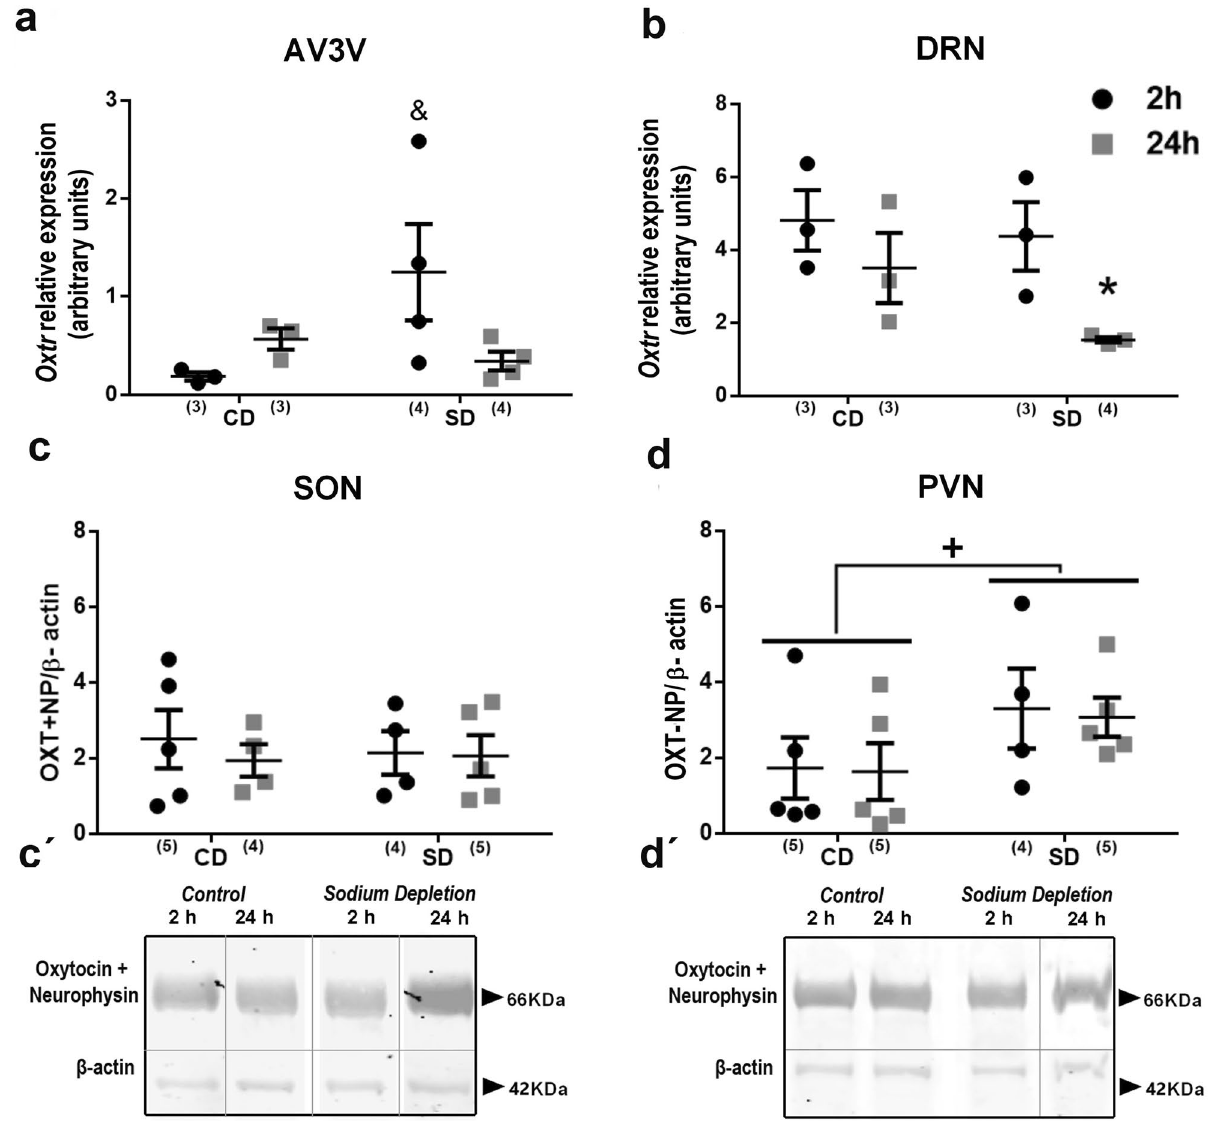
Figure 6. Brain oxytocin system expression after sodium depletion. Relative mRNA levels of oxytocin receptor ( Oxtr ) in the AV3V ( a ) and DRN ( b ) and relative protein expression of Oxytocin + neurophysin (OXT-NP) in the SON ( c ) and PVN ( d ) at two and 24 h after sodium depletion. Western blot detection of OXT-NP protein expressed in SON(c’) and PVN(d’). Values are mean ± SE (number of cases indicated by the individual points in each case). ( a ) & p < 0.05 significant difference between SD two h vs. other groups. ( b ) * p < 0.05 significant difference between SD 24 h vs. other groups. ( d ) + p < 0.05 significant difference between CD vs. SD. SD: Sodium-depleted group. CD: Control group. AV3V: Anteroventral third ventricle area. DRN: Dorsal Raphe Nucleus. PVN: Paraventricular nucleus. SON: Supraoptic Nucleus. Blots: Dividing grey lines indicated non- contiguous lanes from different parts of the same gel. Full-length blots are presented in Supplementary Figure